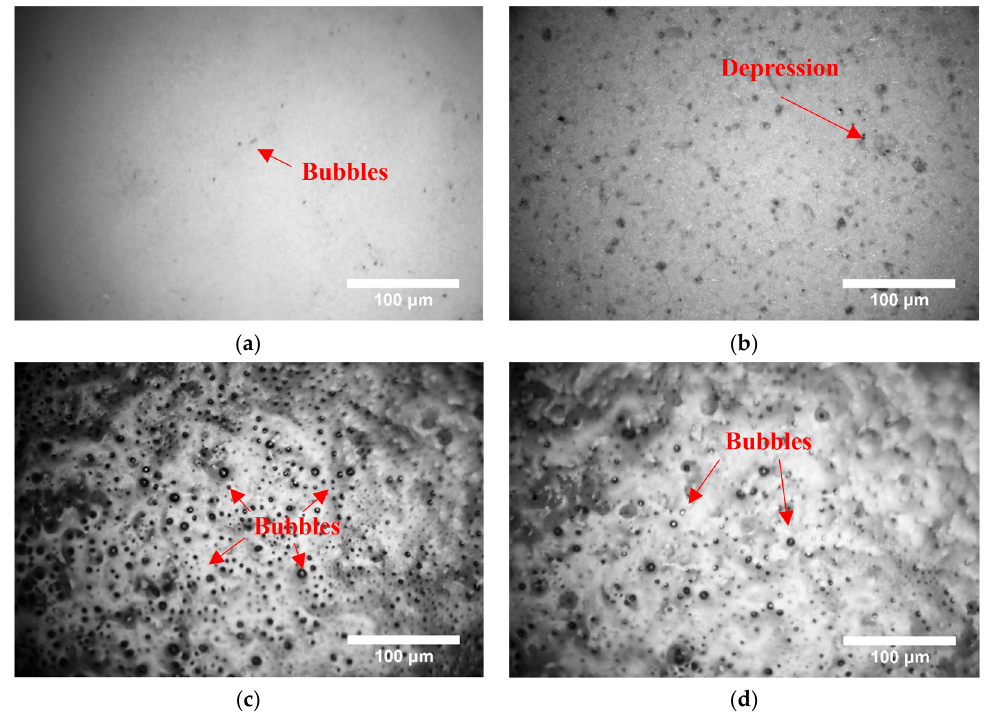
Figure 3. Surface morphology after adding glass powder to PSZ during heating taken by CCD camera: ( a ) 70 °C; ( b ) 150 °C; ( c ) 570 °C; and ( d ) 700 °C.